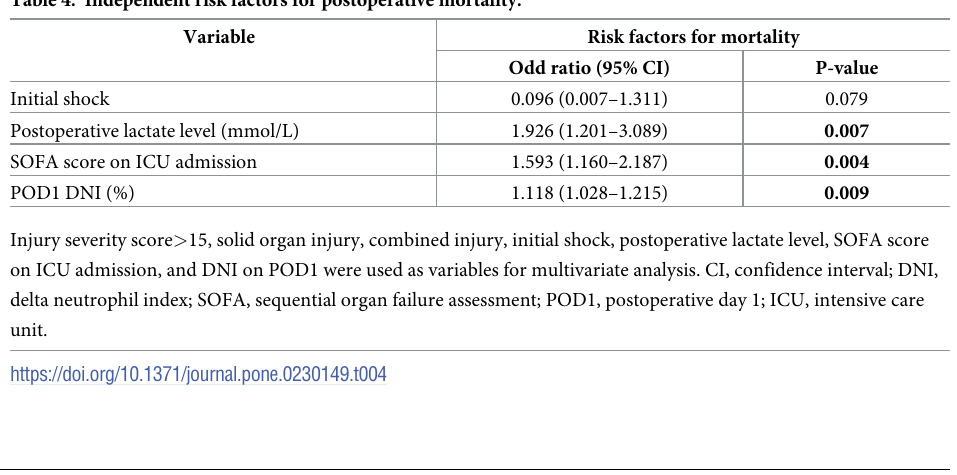
Table 4. Independent risk factors for postoperative mortality.